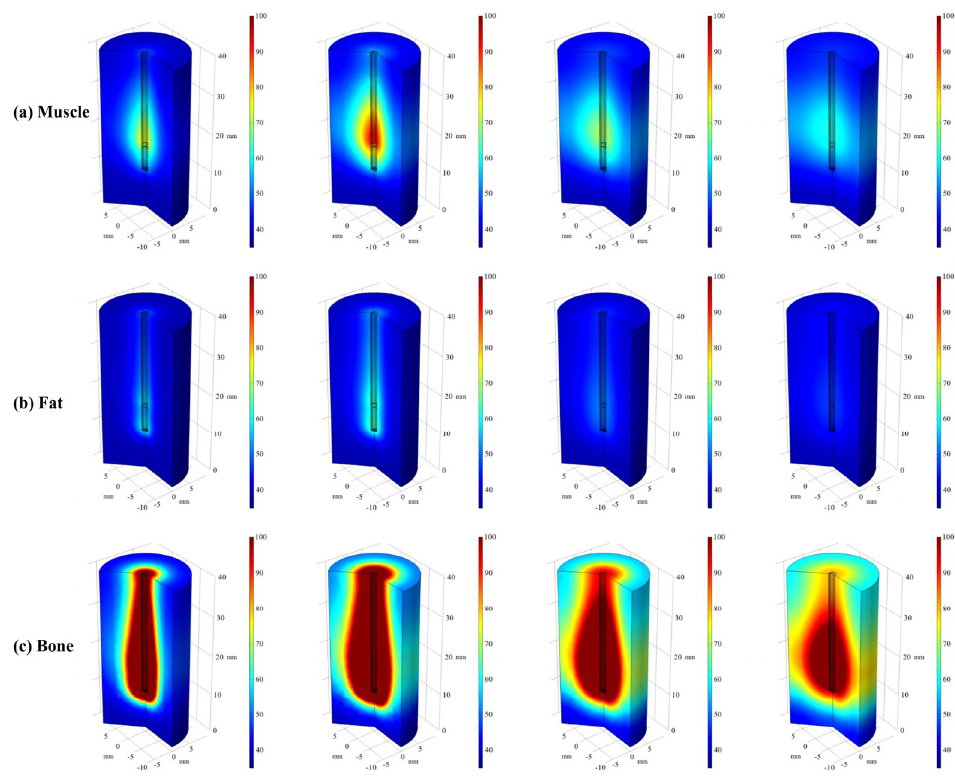
Figure 3. Temperature cloud map at 30 s, 60 s, 90 s, and 120 s. The 30 s and 60 s belong to the heating period, and 90 s and 120 s belong to the cooling period. ( a ) Temperature cloud map of muscle; ( b ) Temperature cloud map of fat; ( c ) Temperature cloud map of bone.